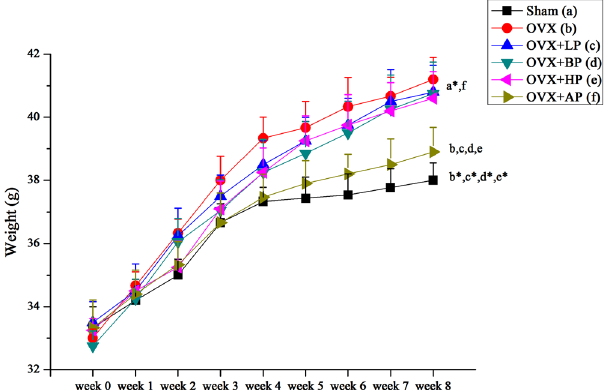
Figure 4. Trends of body weight in Sham, OVX, OVX + LP, OVX + BP, OVX + HP and OVX + AP groups at weeks 0–8 after EMF stimulation. Values represent mean ± SD of 8/group. Letters a-f indicate differences between respective groups at P < 0.05 or * P < 0.01 (a versus Sham; b versus OVX; c versus OVX + LP; d versus OVX + BP; e versus OVX + HP; f versus OVX +